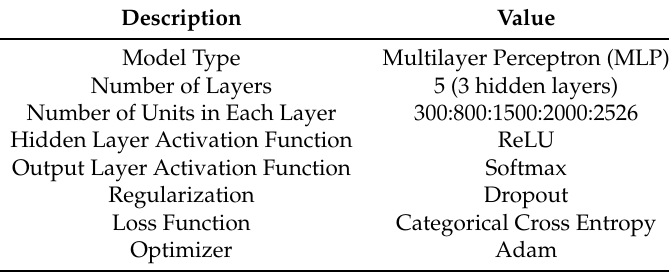
Table 3. A summary of several parameters chosen for our multilayer perceptron (MLP)